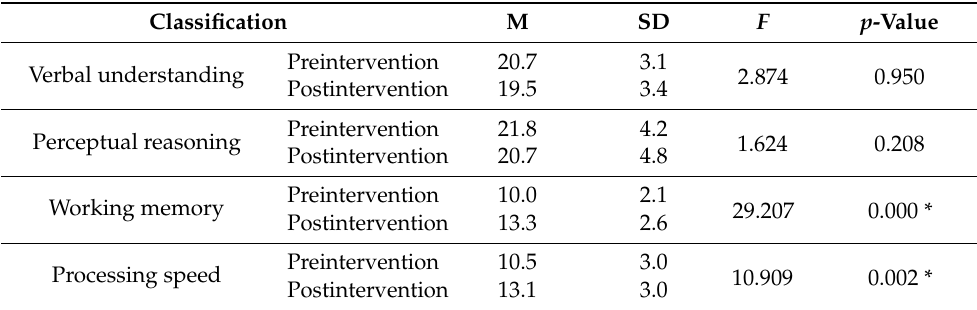
Table 6. Results of intelligence test (K-WISC-IV) sub-items on preintervention and postintervention of the Neuro-World cognitive training program.